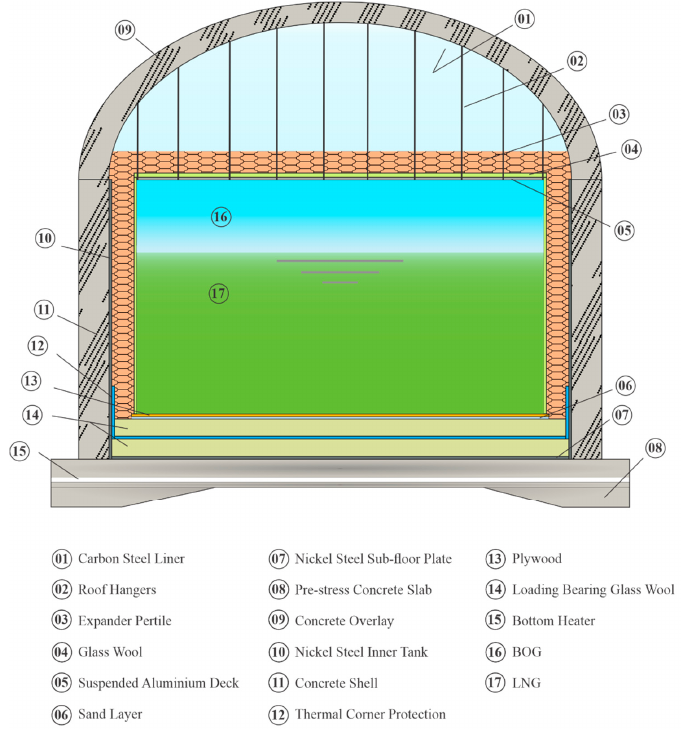
Figure 1. The thermal design of the liquefied natural gas (LNG) storage tank that is considered in the present work. Table 1. Density and specific heat capacity of the insulation materials used in heat leakage